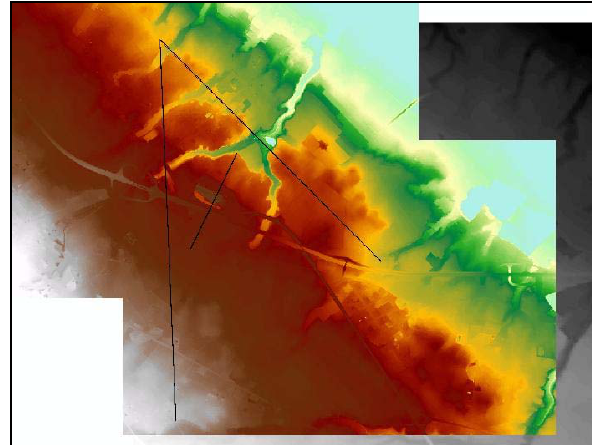
Figure 5. DEM with some profiles (test 2)